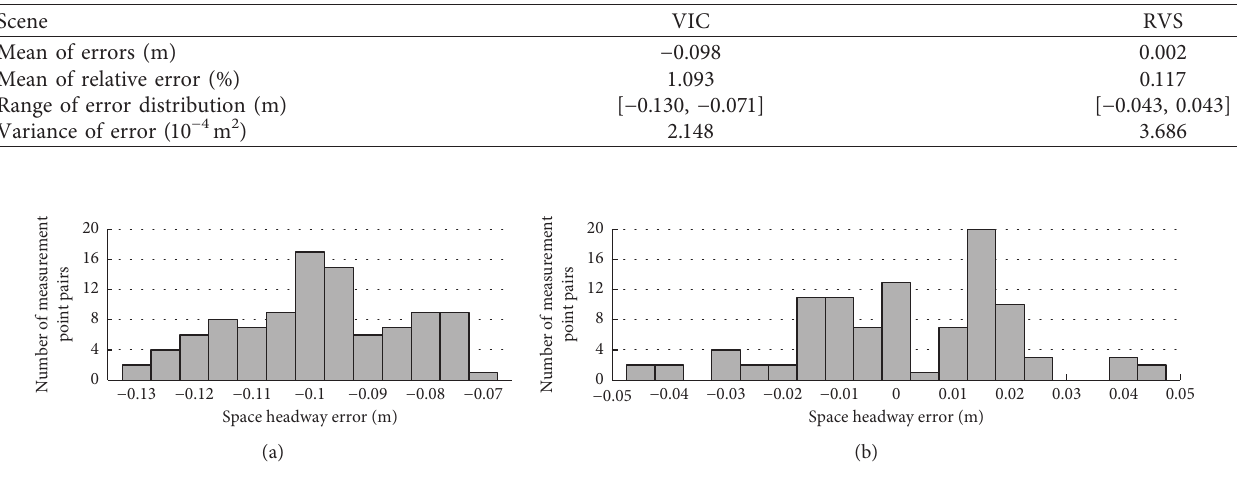
Figure 13: Space headway error distribution: (a) VIC scene and (b) RVS scene.